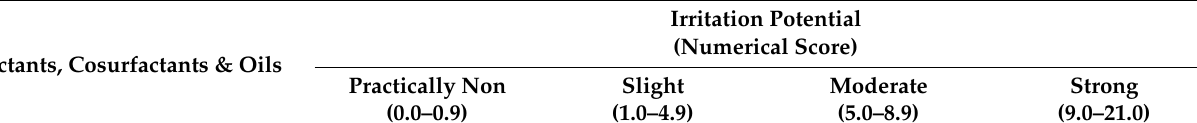
Surfactants, Cosurfactants &